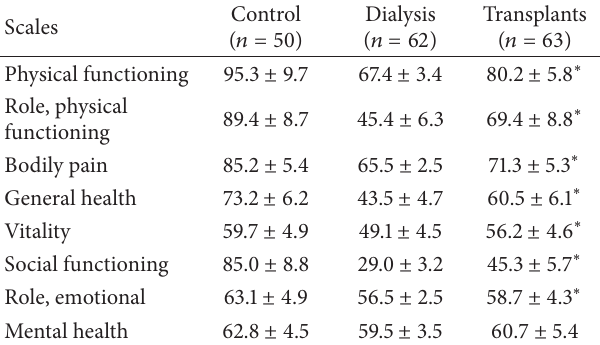
Table 1: Comparative description of life quality indices of patients treated with hemodialysis and the recipients with a satisfactory function of kidney transplant.